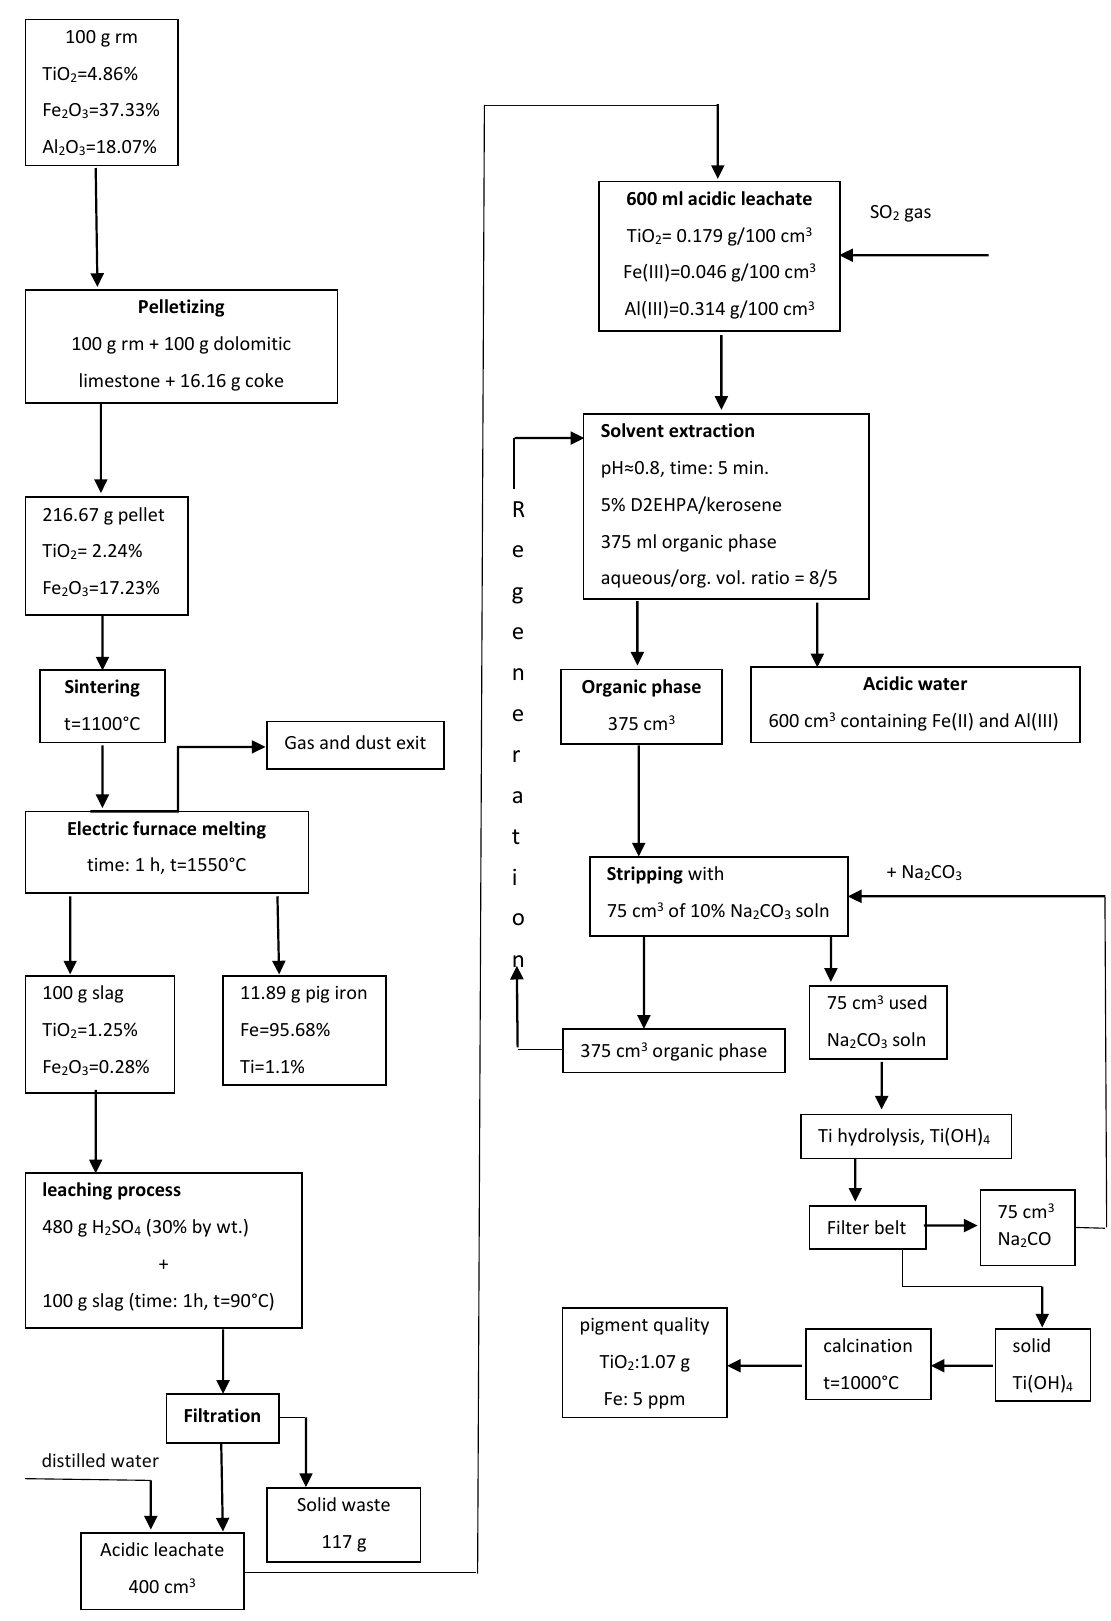
Figure 3. The schematic diagram of comprehensive processing of red mud via reduction roasting–smelting–sulfuric acid leaching–solvent extraction. Reproduced from [13].